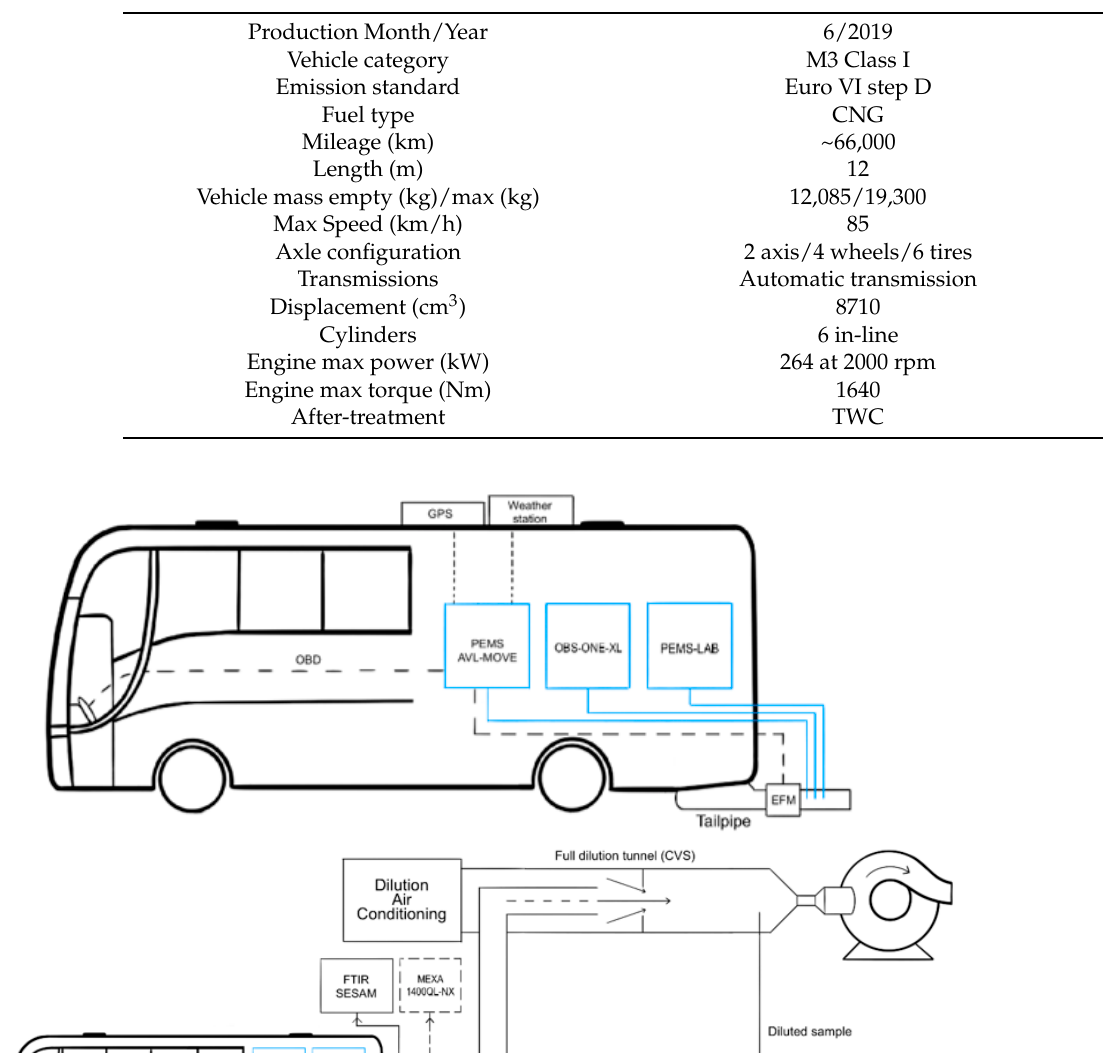
Figure 2. Speed profile of the on-road tests ( top panel ) and WHVC test ( bottom panel ). The AVL MOVE system measures from the exhaust gas concentrations of: CO and CO 2 using a non-dispersive infrared sensor, NO and NO 2 using a non-dispersive ultra- violet sensor, and methane and hydrocarbons using a flame ionization detector. Further- more, this PEMS consisted of: a tailpipe attachment, heated exhaust sampling lines, an exhaust flow meter (EFM), a data logger connected to the vehicle’s on-board diagnostics (OBD) port, GPS, and a weather station for ambient temperature and humidity measure- ments. All relevant emissions data were recorded at a frequency of 10 Hz. Data were re- ported at 1 Hz after being resampled using a 1 Hz moving average window. The OBS-ONE-XL is an on-board emissions measurement system that enables the on- board measurement of NH 3 and N 2 O from vehicle exhaust gas under real-world driving conditions. The system applies Infrared Laser Absorption Modulation (IRLAM) technol- ogy, which is based on infrared absorption spectroscopy, and uses a Quantum Cascade Laser (QCL) as a light source. A QCL can emit light with a very narrow wavelength width in the mid-IR region where many gas components have strong absorption bands. By using